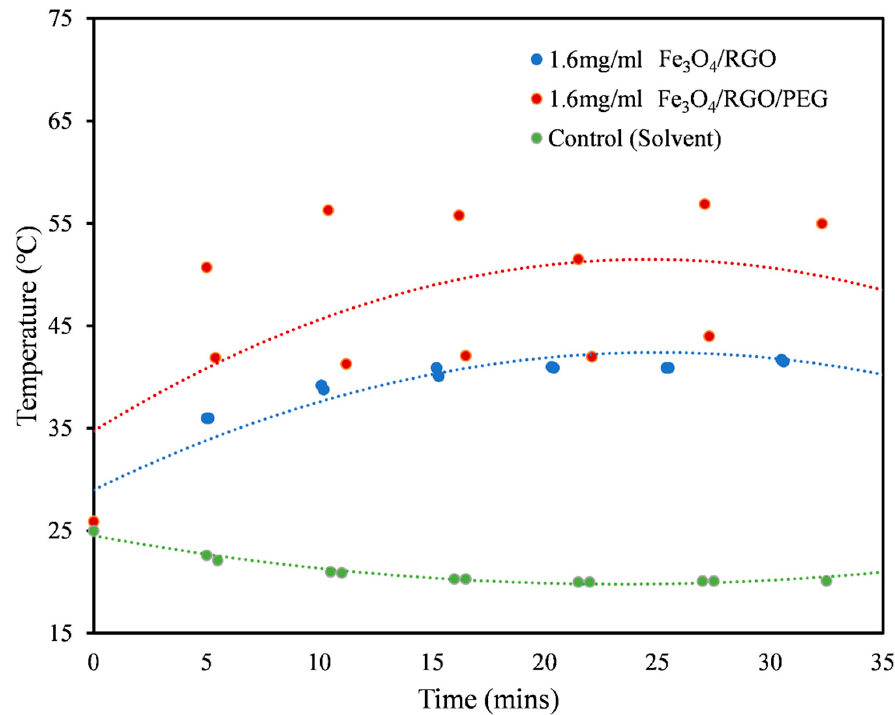
Figure 5. Heating profiles for 1.6 mg/mL solutions of Fe 3 O 4 /RGO (blue) and Fe 3 O 4 /RGO/PEG (red) along with the control (green) in aqueous DMSO medium at magnetic field of 200 A.